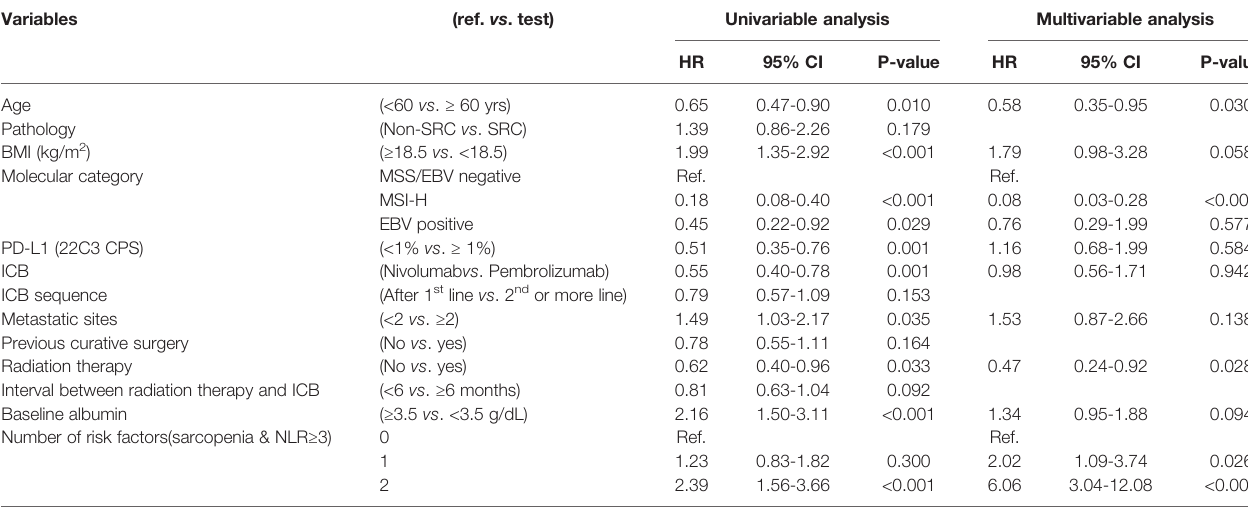
TABLE 3 | Prognostic factors for overall survival. Variables (ref. vs .